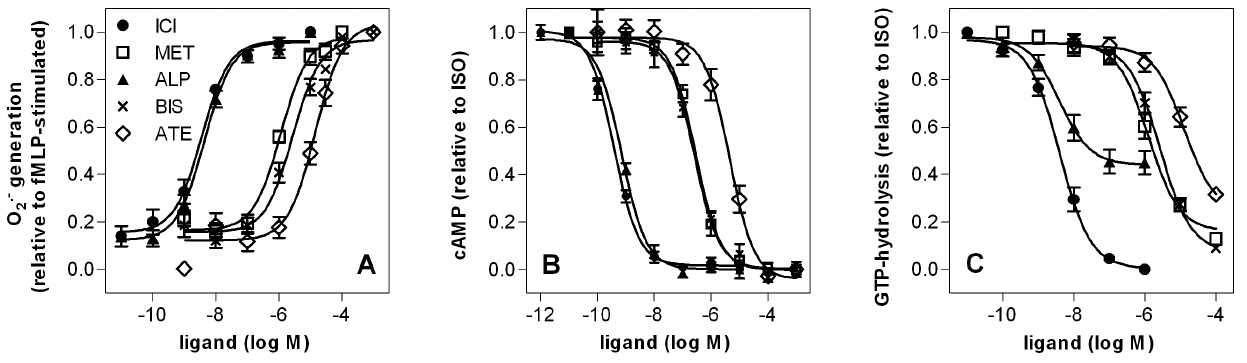
Figure 5. Concentration-response curves for b 2 AR antagonists determined in the O 2 N 2 (A), cAMP (B) and GTPase assay (C). The O 2 N 2 assay (1 6 10 5 cells per well) and the cAMP assay (5 6 10 5 cells per cup) were performed as described in sections 2.3 and 2.4, respectively. Steady-state GTPase activity assay, using membrane preparations of Sf9 insect cells, expressing fusion protein b 2 AR-G s a S , was performed as described in [43]. Data were analyzed by non-linear regression and were best fitted to sigmoidal concentration/response curves. Data shown are the means 6 S.E.M. of four to five independent experiments performed in triplicate. O 2 N 2 and cAMP production as well as GTP hydrolysis were determined at submaximally effective concentration of ISO (100 nM in the O 2 N 2 and cAMP assay, 10 nM in the GTPase assay) in the presence of increasing concentrations of b 2 AR antagonists.